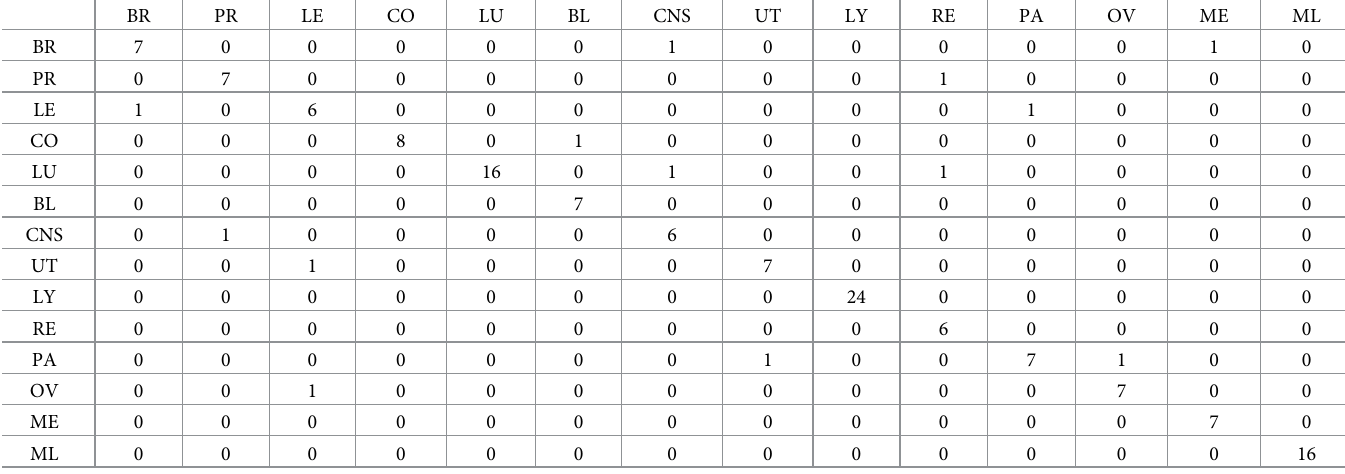
Table 3. A 14 × 14 confusion matrix: Model fittness based on the LR-HeteNet method for the training data T .